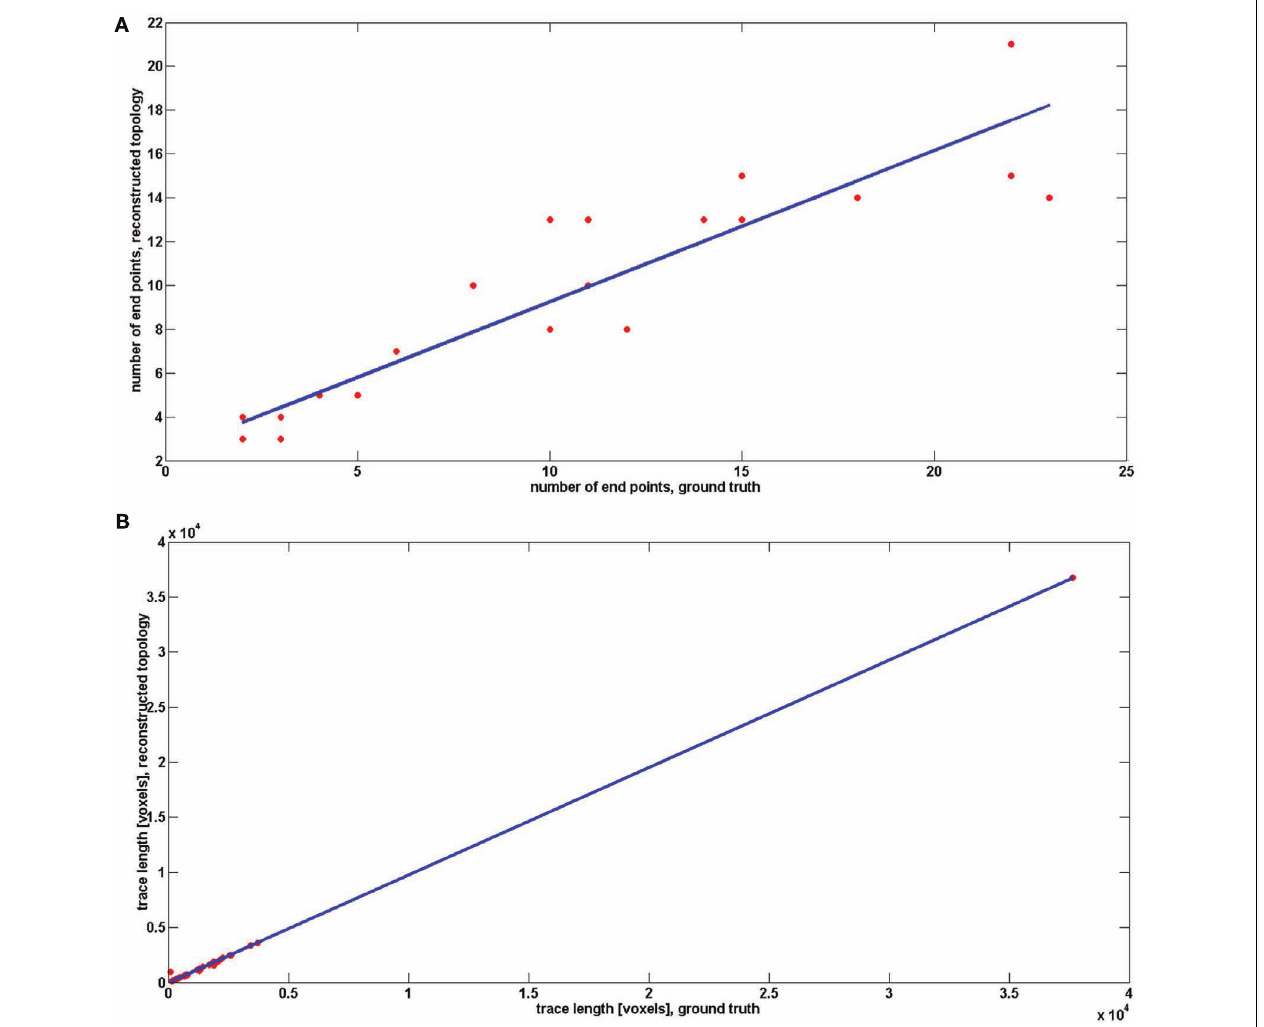
FIGURE 7 | Comparison between number of end points (A) and traces length (B) between reconstructed topology and ground truth. The results